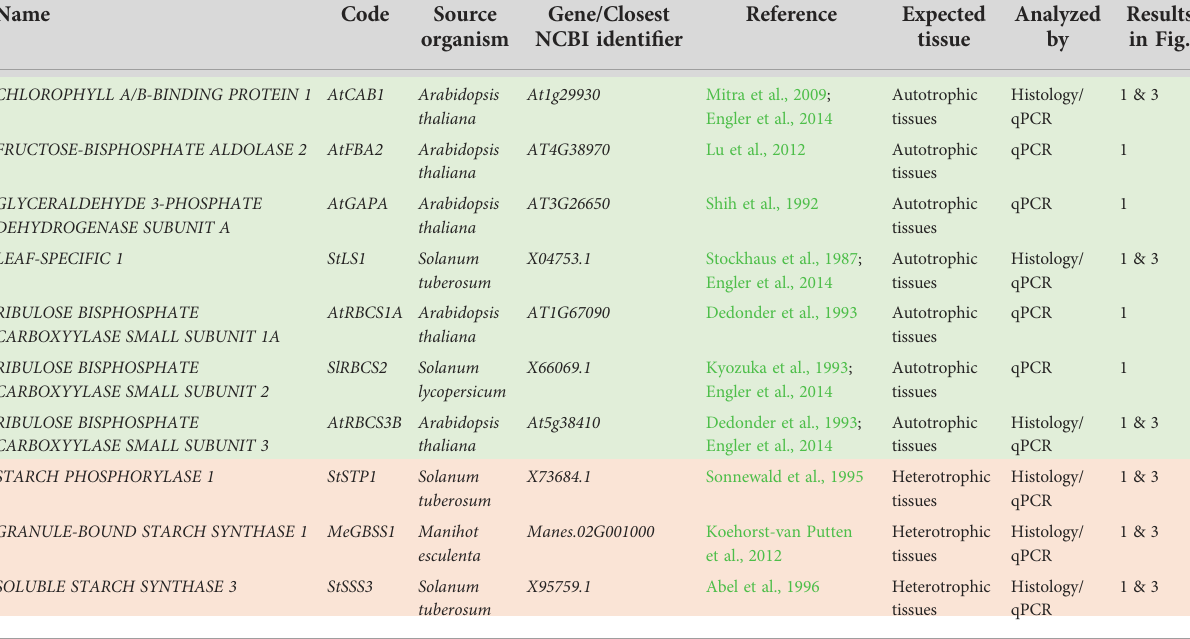
TABLE 1 Summary of 10 promoters assayed via their GUS staining pattern and/or transgene expression in fi eld-grown, transgenic cassava